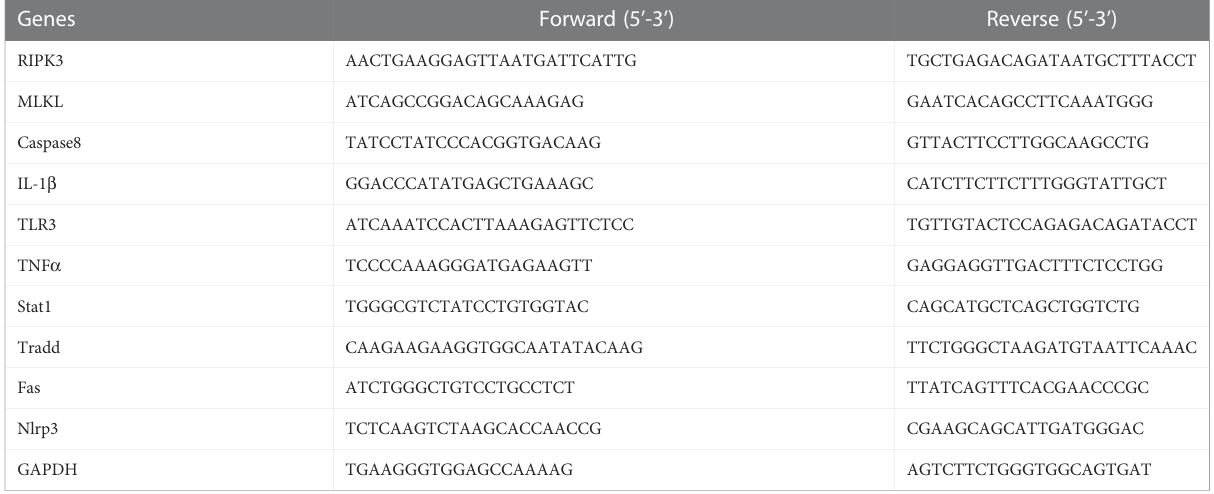
TABLE 1 PCR primers for quantitative real-time PCR.